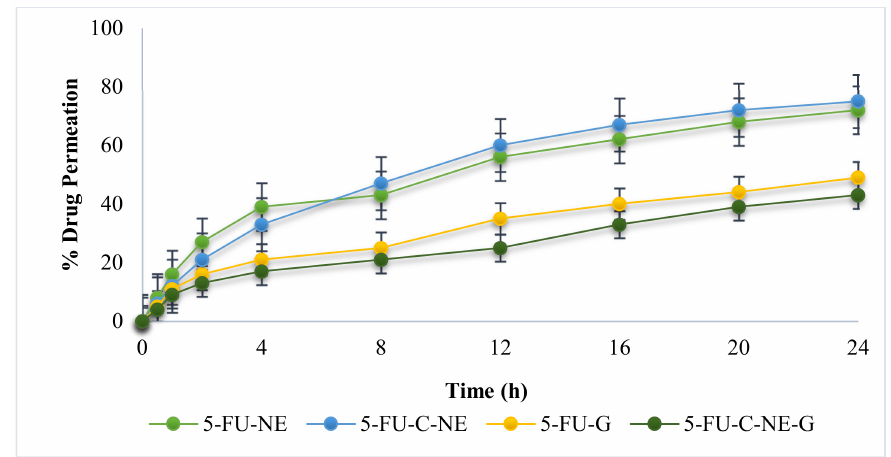
Figure 4. Profile of ex vivo drug permeation.